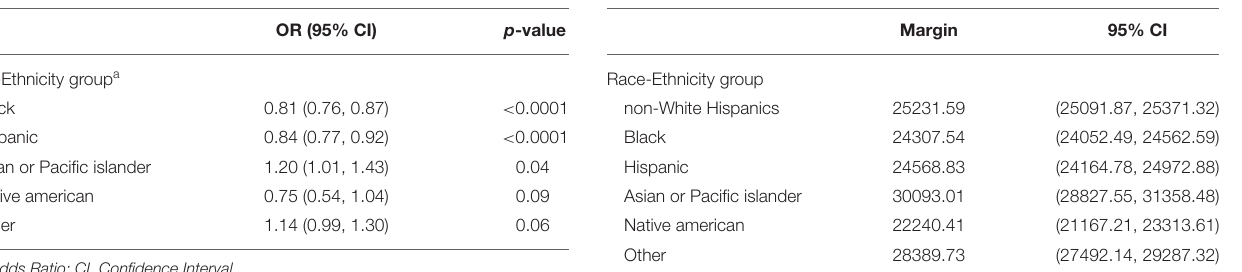
TABLE 6 | Marginal effect analysis of cost, by race-ethnicity